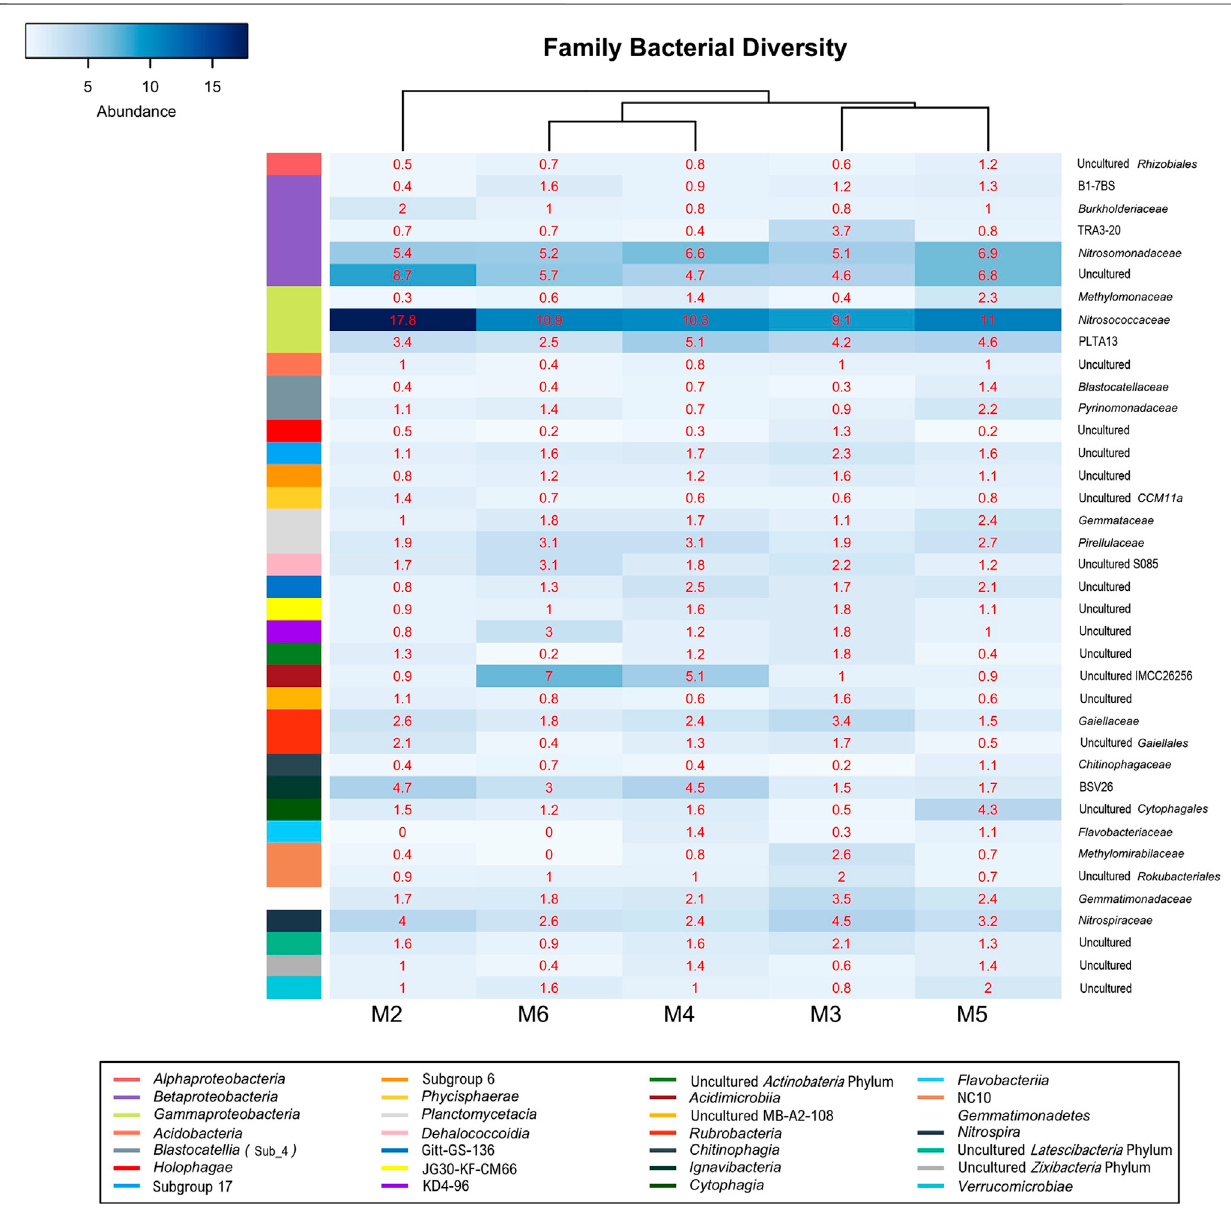
Frontiers in Earth Science |